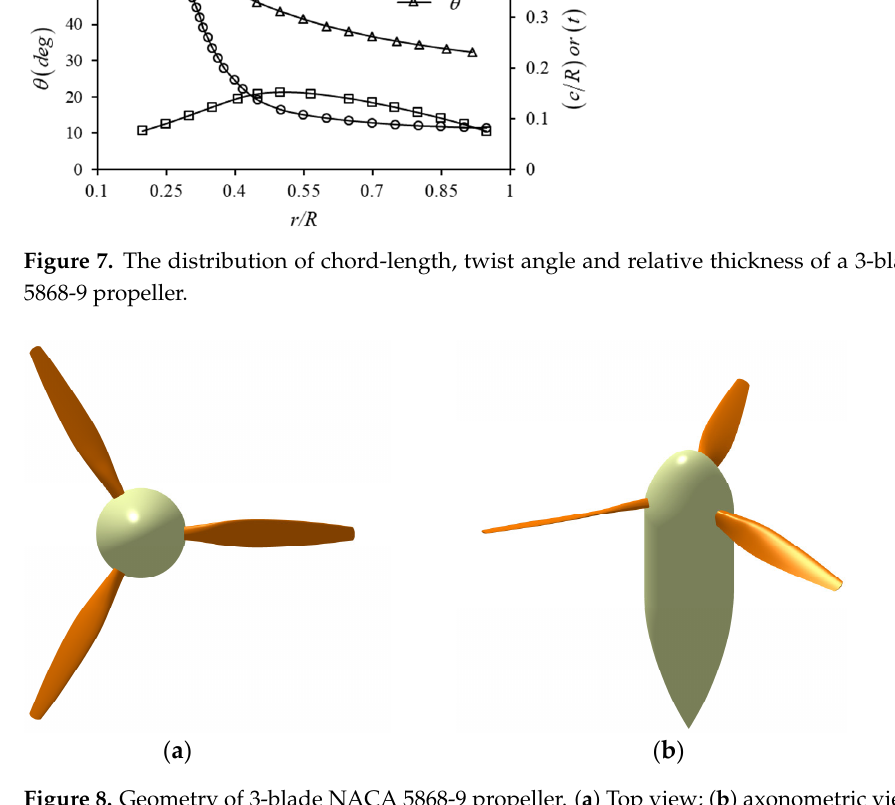
Figure 8. Geometry of 3-blade NACA 5868-9 propeller. ( a ) Top view; ( b ) axonometric view.